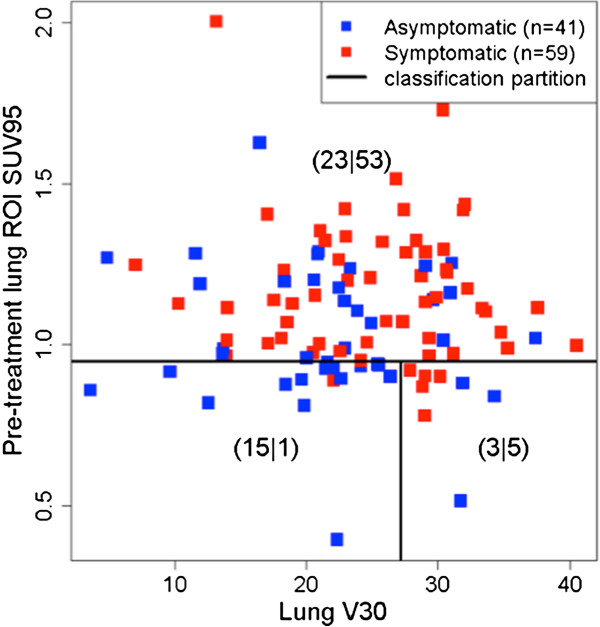
Classification of symptomatic and asymptomatic RP against SUV95 and V30. Recursive partition analysis for classification of RP symptoms using pre-treatment SUV95 and V30 for N = 100 lung cancer patients results in 3 cohorts. The optimal partition derives from classifying patients with pre-treatment SUV95 > 0.949 or V30 > 27.14 as symptomatic, and those with SUV95 < 0.949 and V30 < 27.14 as asymptomatic. The joint classification tree results in sensitivity = 98% and specificity = 37%.